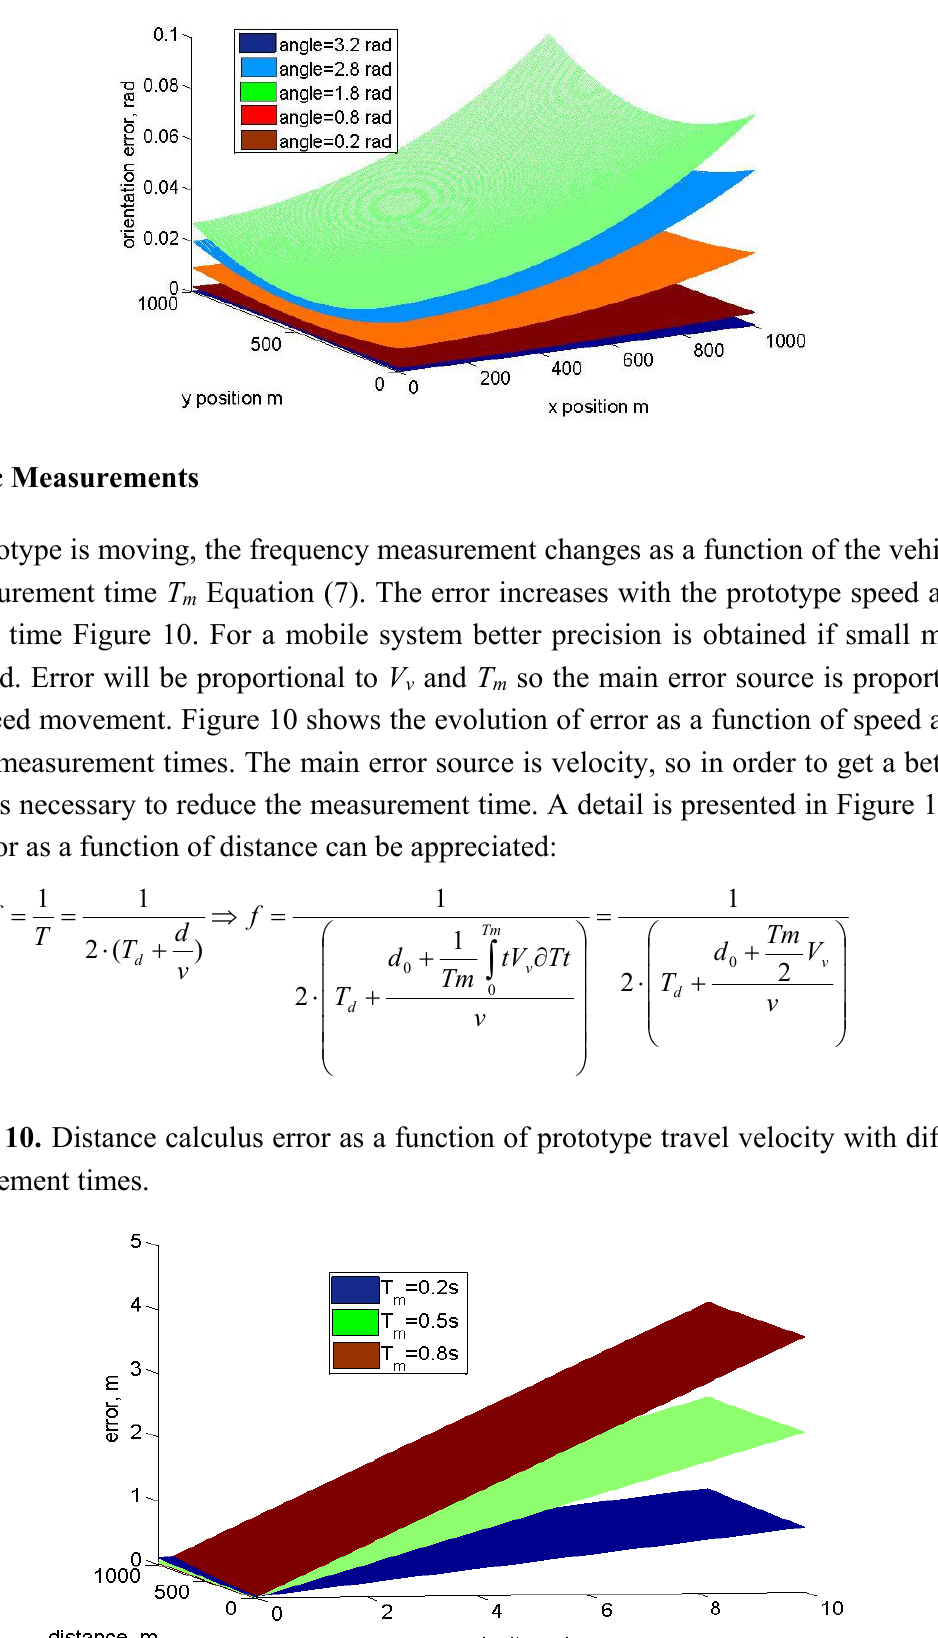
Figure 9. Orientation error angle as a function of Cartesian position for a distance between sensors of 1 m, each graph represents a different orientation.